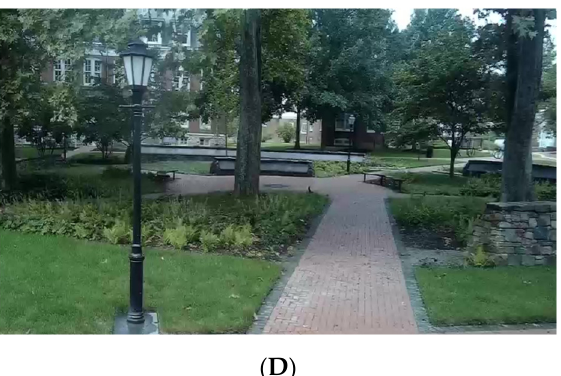
Figure 3. Examples of nodes ( A ): entrances/exits to campus buildings; ( B ): narrow walkway; ( C ): crosswalks; ( D )—public open spaces.